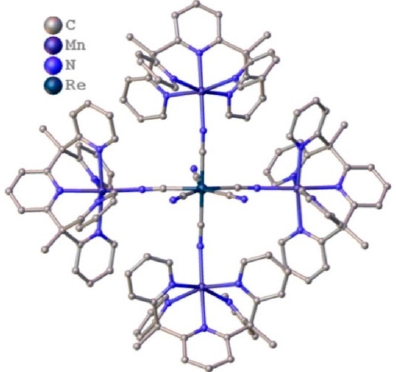
Figure 1. Cross-like geometry of the pentanuclear cations of [(Py 5 Me 2 ) 4 Mn 4 Re(CN) 7 ](PF 6 ) 5 ·6H 2 O ( 4) and [(Py 5 Me 2 ) 4 Mn 4 Re(CN) 7 ](PF 6 ) 4 ·10H 2 O ( 5 ). Hydrogens atoms are omitted for clarity. coupling between the metal ions, an S = 21 / 2 ground state, with axial ZFS of D = − 0.44 cm − 1 , as the SMM parameters of 4 : U eff = 33 cm − 1 and τ 0 = 2.4 × 10 − 8 s. Under ambient conditions, with four noninteracting Mn II centers [3].